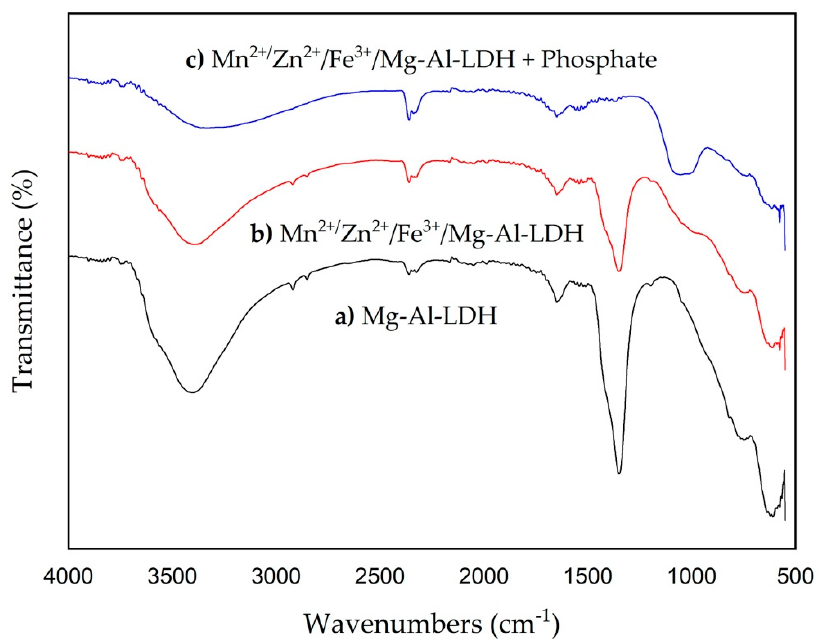
Figure 3. FTIR spectra of the LDH materials ( a ) Mg-Al-LDH, ( b ) Mn 2+ /Zn 2+ /Fe 3+ /Mg-Al-LDH composite, and ( c ) P-loaded Mn 2+ /Zn 2+ /Fe 3+ /Mg-Al-LDH composite.